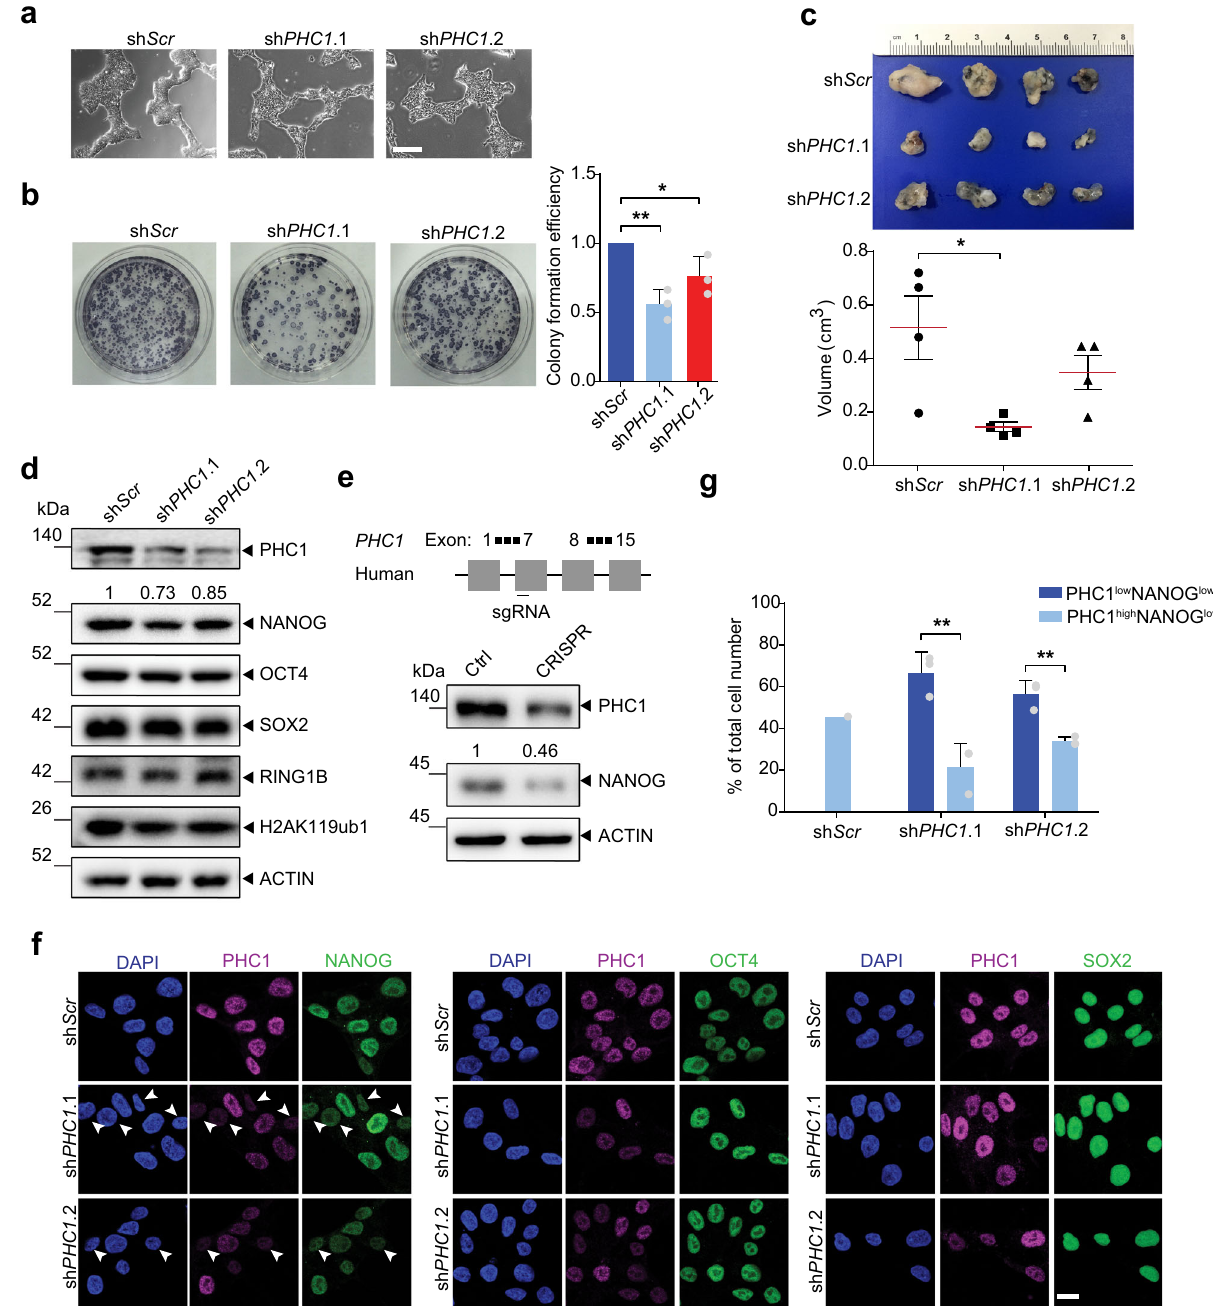
Fig. 2 PHC1 is required for the pluripotency maintenance of hESCs. a , b Morphology and colony-forming capacity of sh Scr -, sh PHC1 .1-, and sh PHC1 .2- infected hESCs. Scale bars, 600 μ m. Cells were stained for alkaline phosphatase activity 14 or 18 days after plating. Bar plot shows mean colony- formation ef fi ciencies normalized to the sh Scr . Mean ± s.d. of n = 3 independent experiments. Two-tailed unpaired t -tests were used ( ** p = 0.0022, * p = 0.0458). c Comparison of tumor sizes about 1 month after injection of sh Scr -, and sh PHC1 -infected hESCs into NOD/SCID mice. Data are presented as mean ± s.e.m. In each group, 4 NOD/SCID mice were injected. Two-tailed unpaired t -tests were used ( * p = 0.0211). d WB analysis of PHC1, NANOG, OCT4, SOX2, RING1B, H2AK119ub1, and ACTIN protein levels in sh Scr and sh PHC1 -infected hESCs. e WB analysis of PHC1 and NANOG protein levels in hESCs infected with control and CRISPR-CAS9 vector targeting human PHC1 gene. f Immuno fl uorescent co-staining of PHC1 with NANOG, OCT4, or SOX2 in sh Scr - and sh PHC1 -infected hESCs. Arrowheads showed cells with low PHC1 and NANOG signals. Scale bars, 20 μ m. g The ratios of cells exhibiting PHC1 high NANOG low and PHC low NANOG low signals to the total number of stained cells in ( f ) were quanti fi ed. Mean ± s.d. of n = 3 independent counts for sh PHC1 .1 and sh PHC1 .2. Two-tailed unpaired t -tests were used ( p = 0.0065 for sh PHC1 .1, p = 0.0048 for sh PHC1 .2). Source data are provided as a Source Data fi